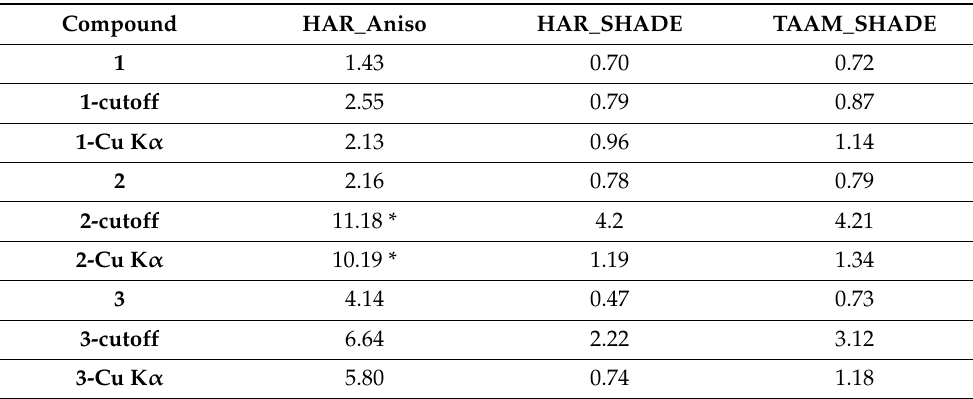
Table 4. The mean similarity index S obtained from refinements against the high-resolution datasets